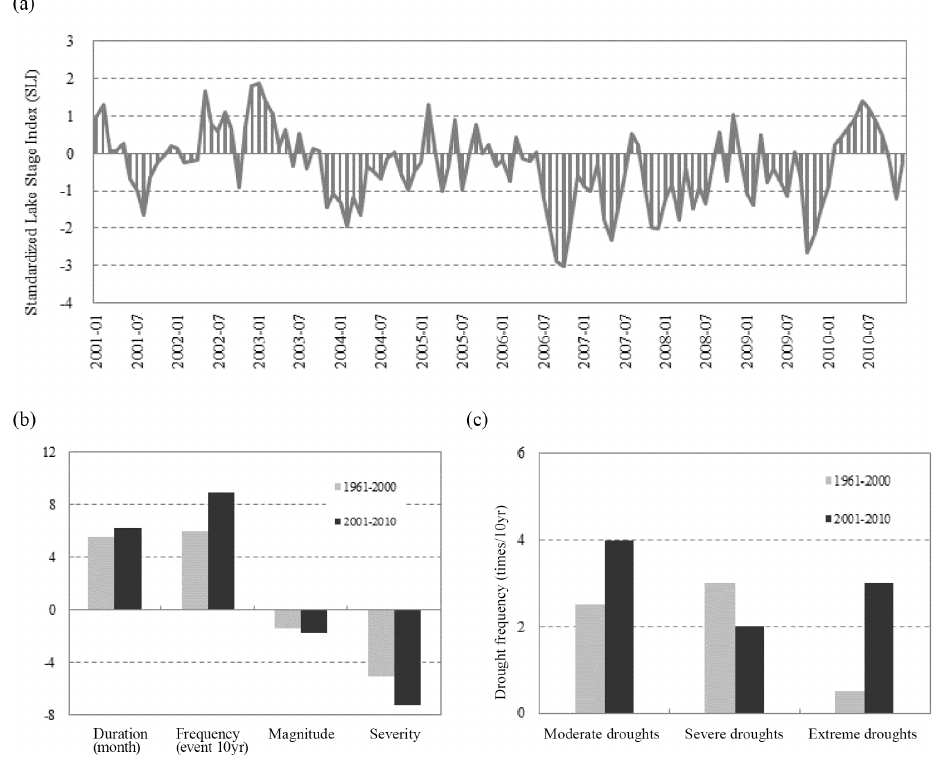
Figure 3. Poyang Lake droughts in 2001–2010. (a) Variation in the standardized lake stage index (SLI). (b) Drought duration, frequency, intensity and severity, and (c) Drought frequency for moderate, severe and extreme droughts, compared to 1961–2000. Table 1. Drought events occurring during the 2001–2010 time period. No. Period Duration Intensity Severity Drought (month)